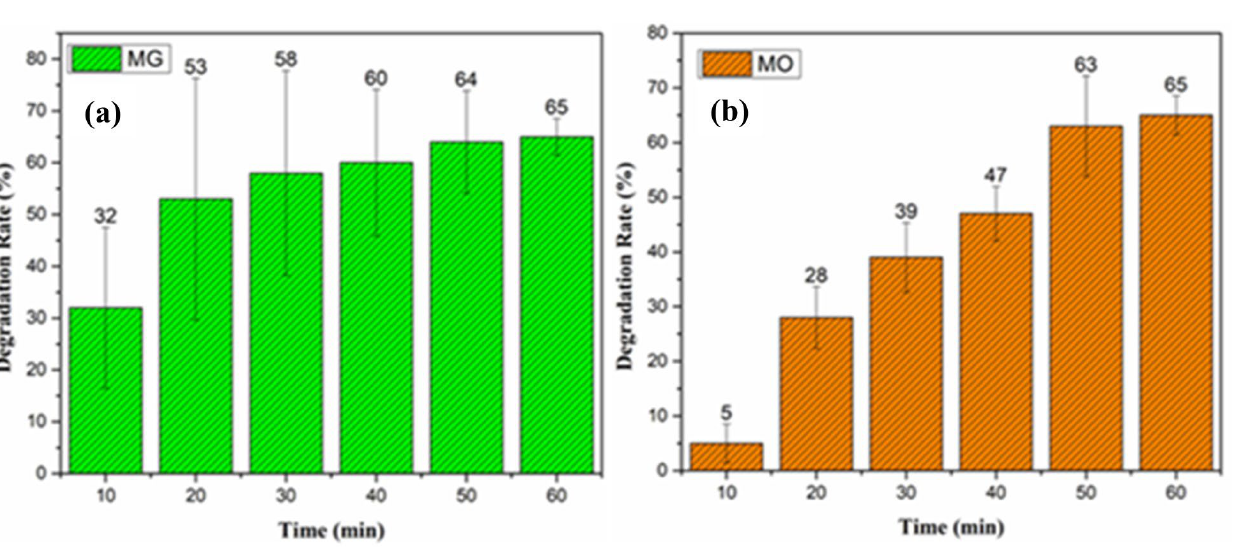
Figure 8. Degradation rate of ( a ) MG and ( b ) MO dyes. Table 1. Degradation rates (%) and rate constants for photocatalytic degradation of dyes using bio- genic CuO NPs.